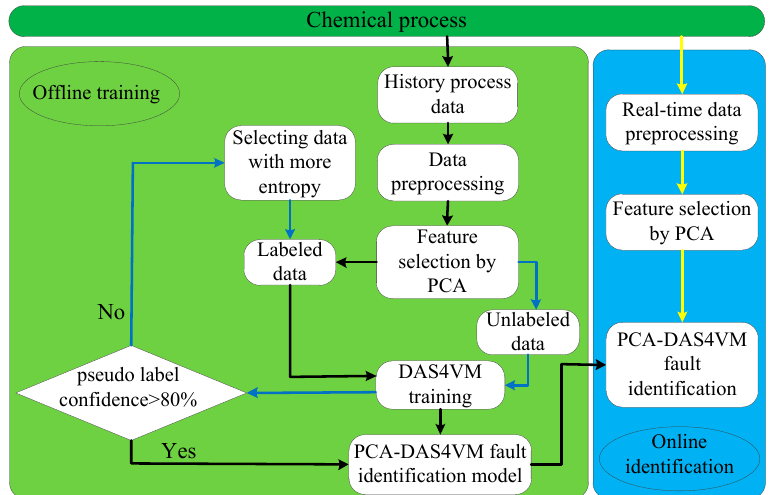
Figure 1. The framework of the PCA-dynamic active safe semi-supervised support vector machine (PCA-DAS4VM) based fault identification